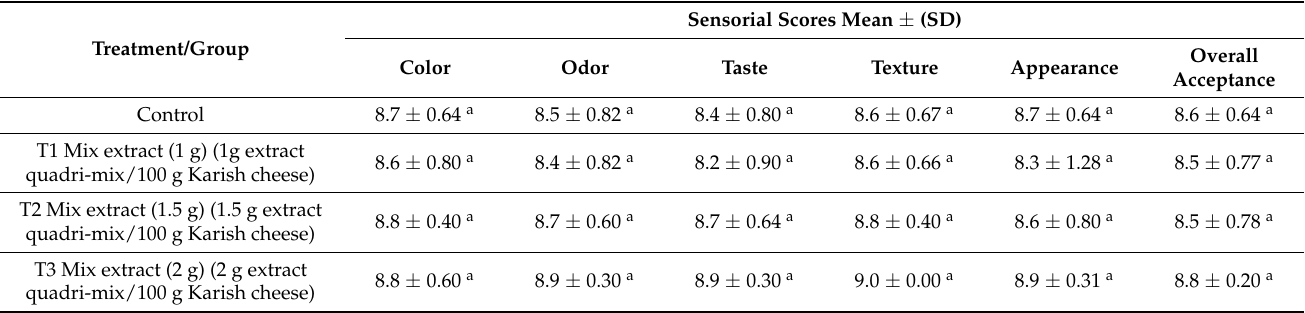
Table 4. Sensorial scoring of extract quadri-mix-fortified Karish cheese.